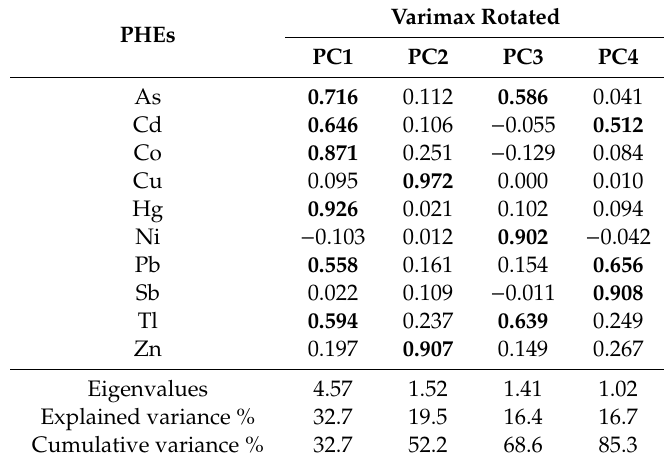
Table 4. Factor loading results obtained from the principal components analysis (PCA). Varimax Rotated PHEs PC1 PC2 PC3 PC4